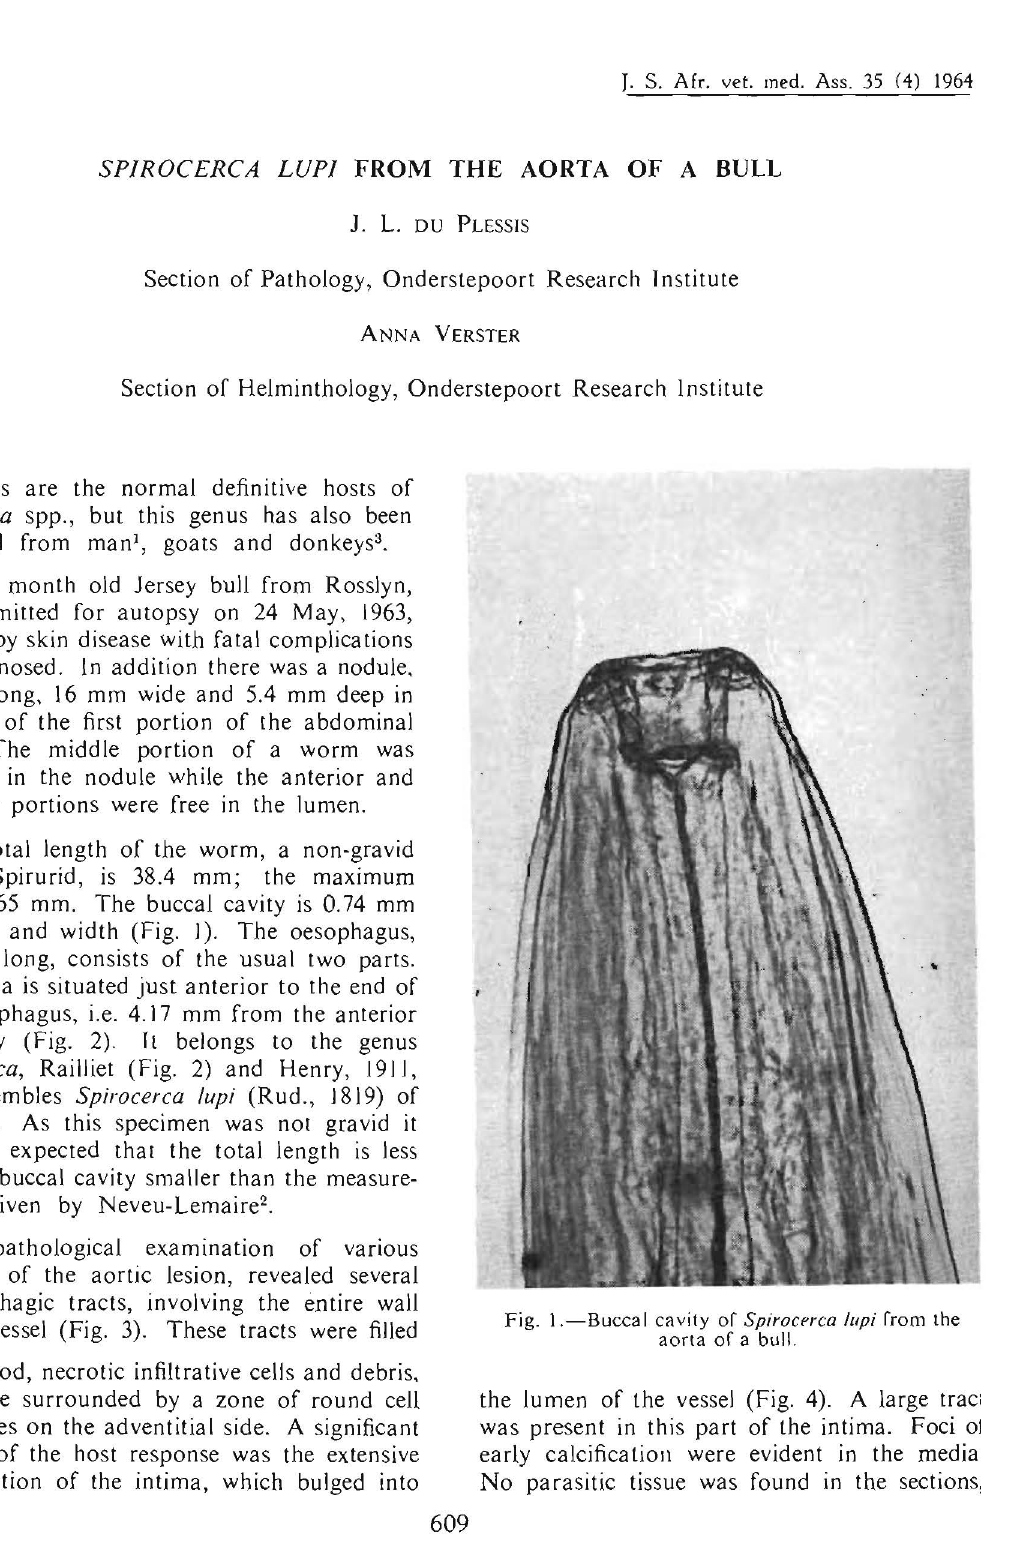
Fig. I.-Buccal cavity or SpirocPrca /upi rrom the aorta or a bull. the lumen of the vessel (Fig. 4). A large trac, was present in this part of the intima. Foci 01 early calcificatioll were evident in the media No parasitic tissue was found in the